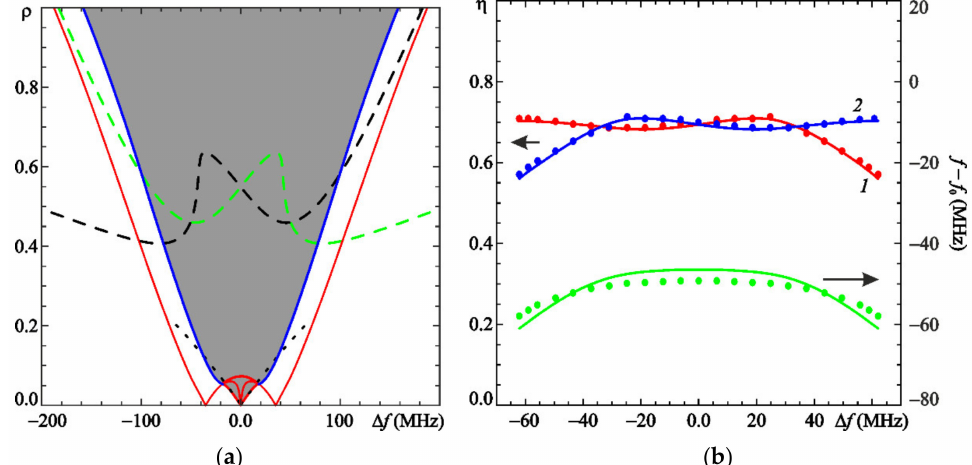
Figure 4. ( a ) Locking domain on the ∆ f , ρ -plane at µ = 15.0, ∆ H = 0.534, I 0 = 0.05, and ψ = 0.2 π (shaded). Boundaries of saddle-node and Andronov–Hopf bifurcations are shown with red and blue lines, respectively. Dashed lines show the stability boundaries of the regimes when one gyrotron suppresses the other. Dotted line shows the locking boundary obtained from the generalized Adler’s equation (Section 3.2). ( b ) Efficiencies of the first and second gyrotrons and oscillation frequency versus ∆ f at ρ = 0.3. The results of simulation of the DDE model (10) at ψ = π and τ d = 3.0 are shown with